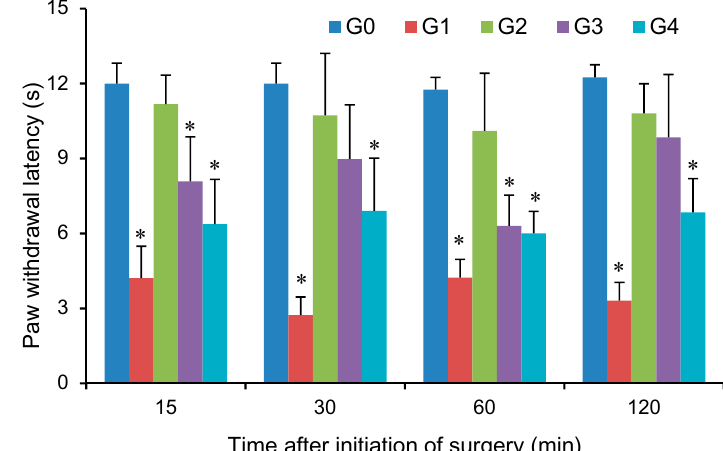
Figure 6. Thermal pain sensitivity indicating by paw withdrawal latency (PWL, Hargreaves test) among different groups. G0, no treatment; G1, topical application of blank hydrogel + iontophoresis; G2, topical application of FBF hydrogel + iontophoresis; G3, topical application of a marketed FBF hydrogel patch (cataplasms) and G4, oral administration of FBF suspension. n = 6; * P < 0.05 compared with the baseline of G0 group.